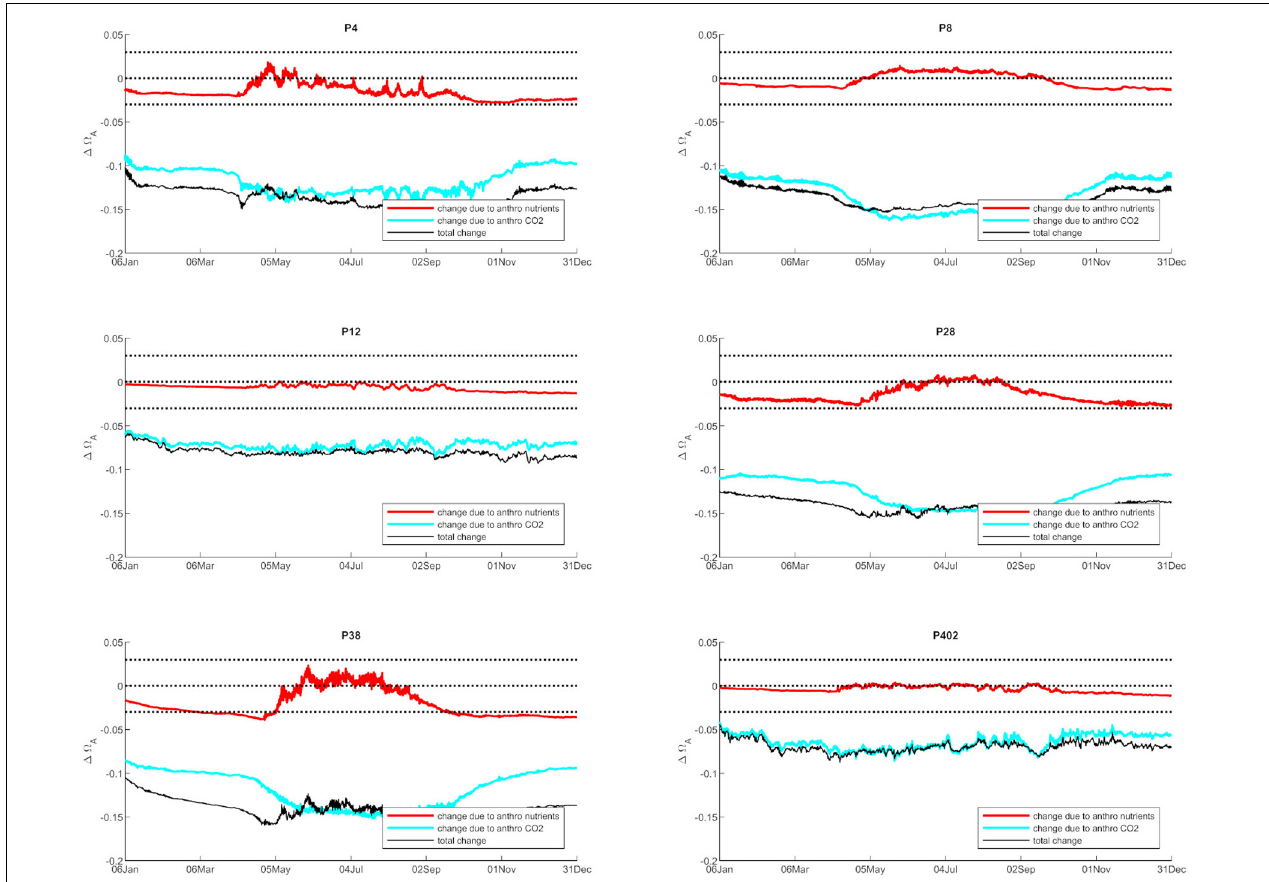
FIGURE 4 | The changes in (cid:127) ar due to anthropogenic nutrients (red line) and atmospheric CO 2 (blue line), while the black line represents the total change from both nutrients and atmospheric CO 2 at six selected stations in Puget Sound (P4, P8, P12, P28, P38, P402 with locations shown in Figure 1